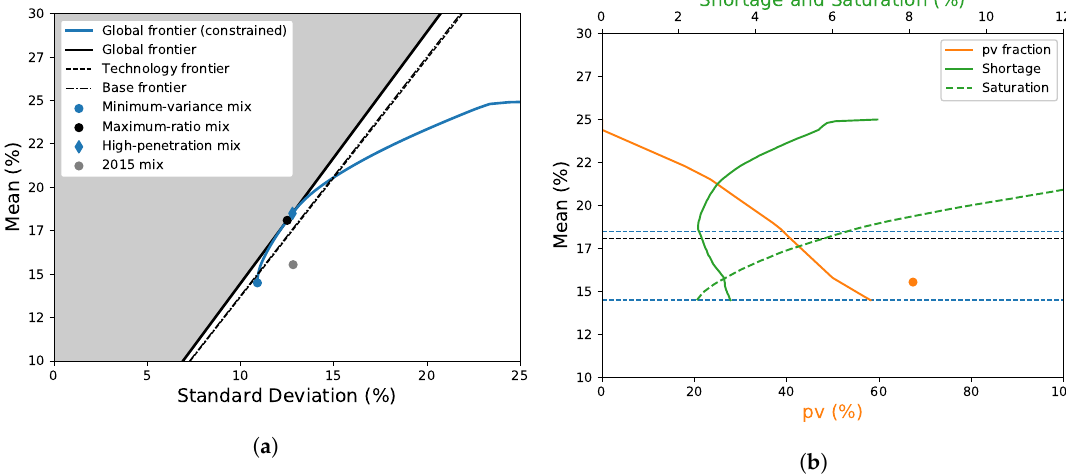
Figure 4. ( a ) Approximations of the optimal frontiers from the CORDEX hourly data with the global standard deviation σ global (2) in abscissa and the mean penetration µ (1) in ordinate. The thick plain curves represent numerical approximations of the frontiers for the global strategy with (plain blue line) and without (plain black curve) the total-capacity constraint (5c). The dashed and point-dashed black lines represent the optimal frontier for the technology and the base strategies without the total-capacity constraint. The black dot, blue dot and blue diamond represent the maximum-ratio mix, the minimum-variance mix and the high-penetration mix, respectively. ( b ) Fraction of PV capacity in the mix (plain orange line); shortage frequency (plain green line); saturation frequency (dashed green line) (x axis); versus the mean penetration, for the global strategy with the total-capacity constraint (y axis). The blue and black dashed horizontal lines mark the mean-penetration values corresponding to the blue and black dots and the blue diamond on the left panels. The orange dot represents the PV ratio for the actual capacities installed in Italy in